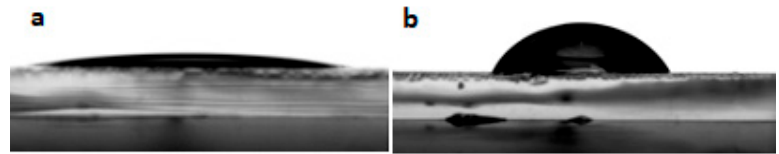
Figure 4. Contact angle on an ITO plate without ( a ) and with ( b ) a deposited heptazine layer.